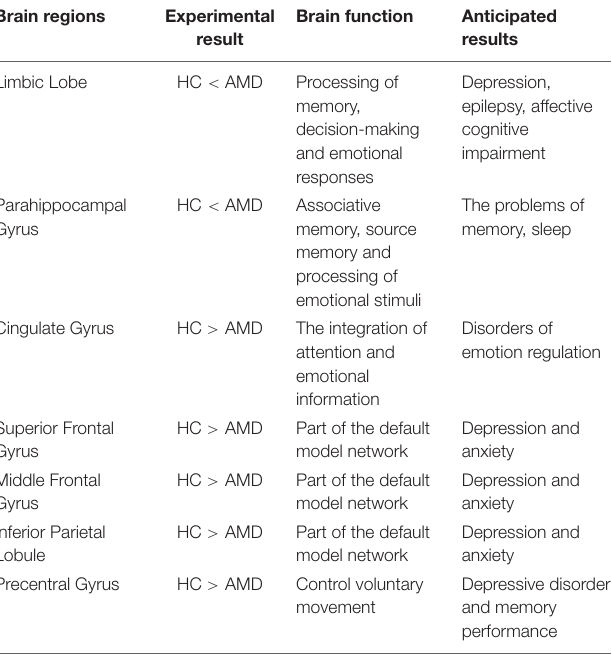
TABLE 4 | Brain regions alternation and its potential